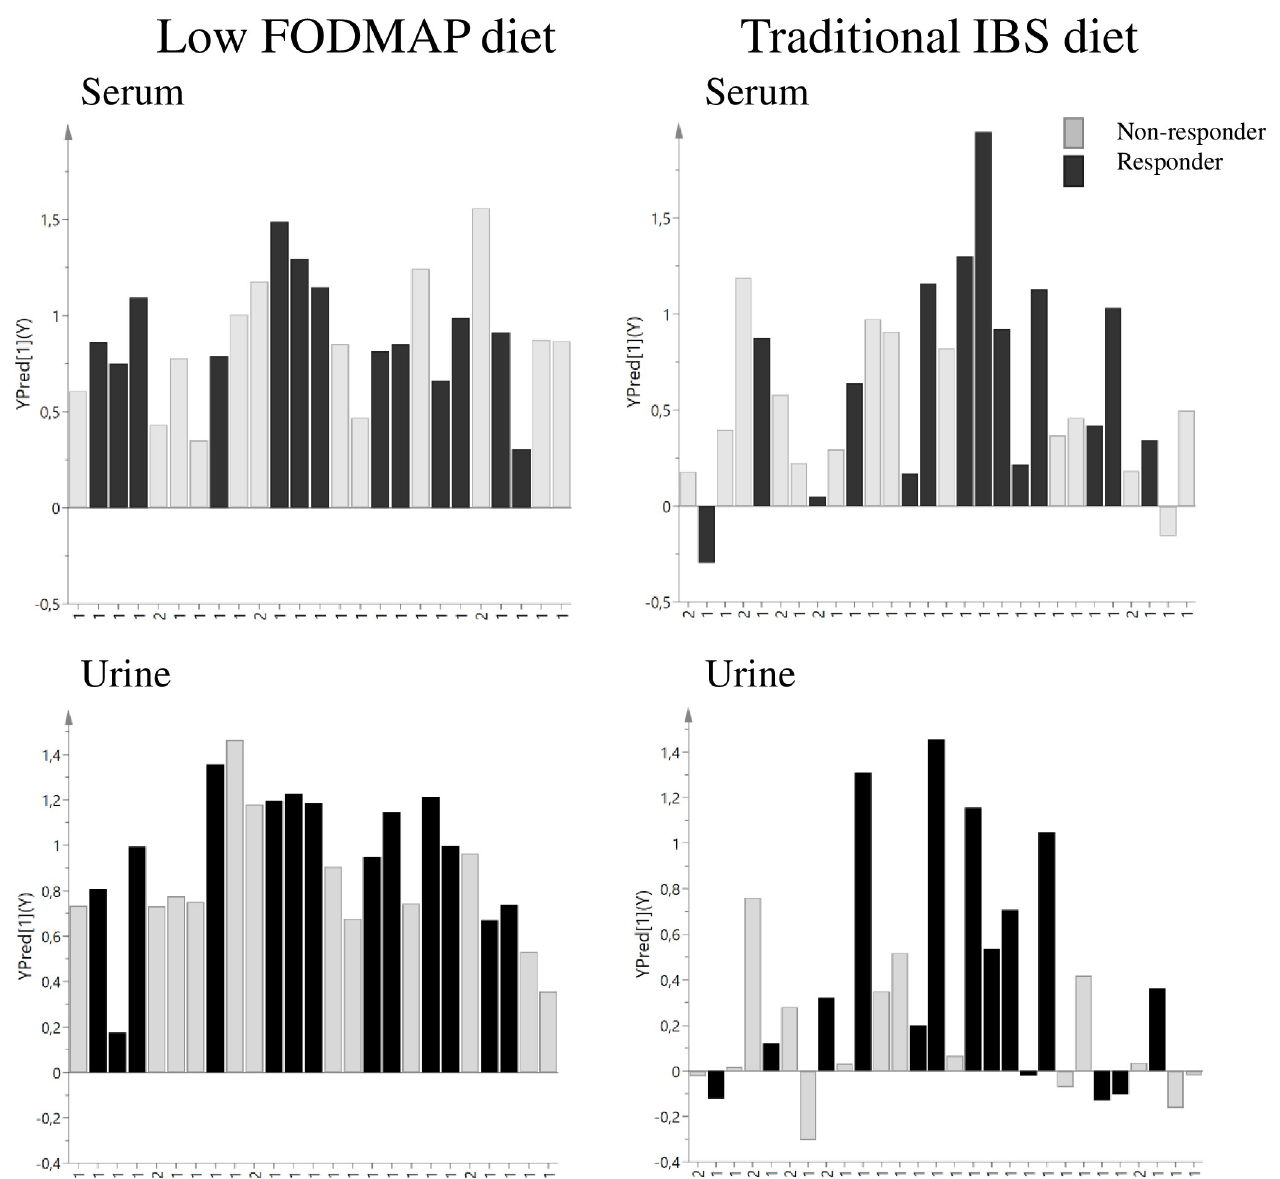
Fig 2. Observed response (YObs) in relation to predicted response (YPred) in the low FODMAP diet and traditional IBS diet in serum and urine samples, colored according to responders and non-responders and labeled 1 = women and 2 = men. YObs = 1 indicates a perfect match between observed and predicted values and variables with large positive or negative residuals are those differing with respect to the systematic structure captured by the